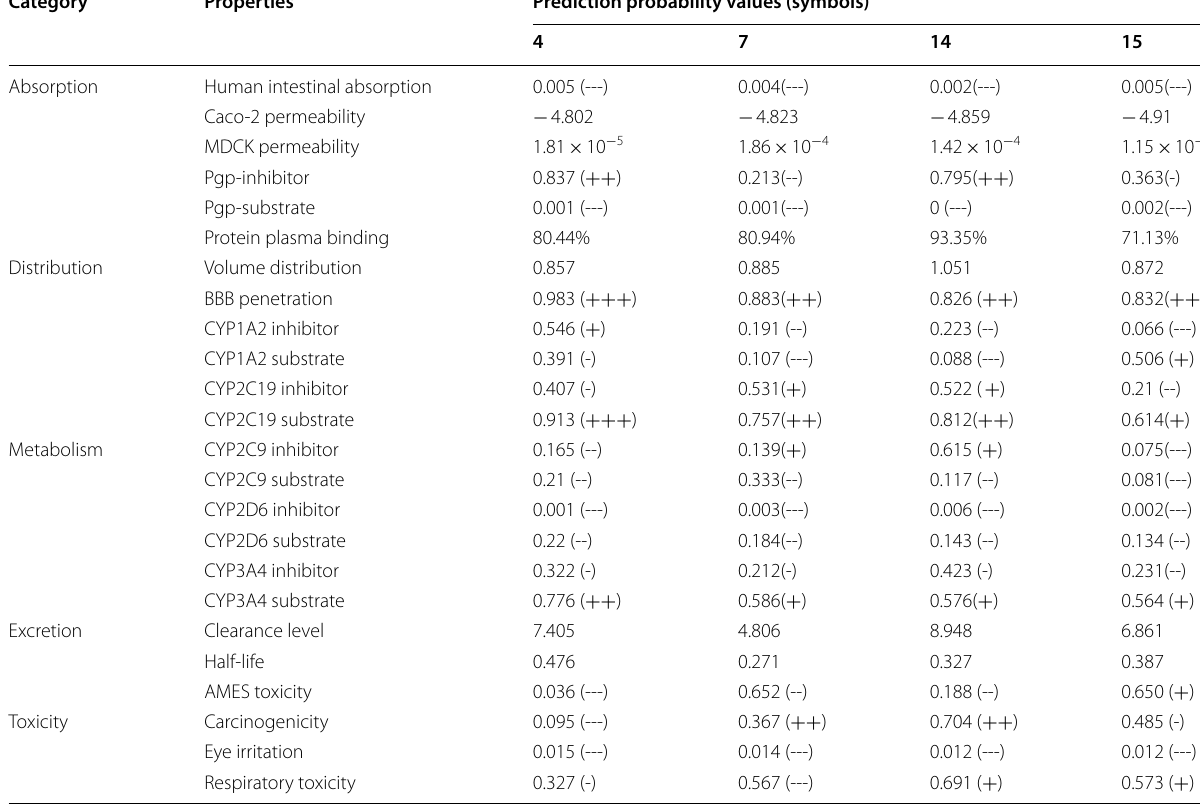
Table 17 ADMET properties of the lead